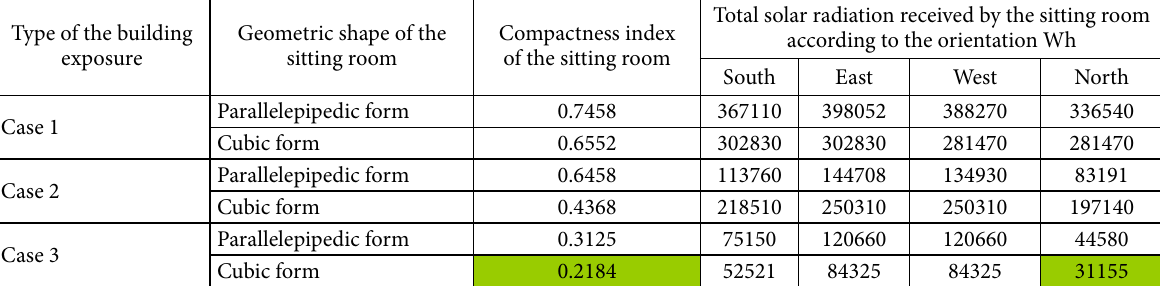
Table 5. Total solar radiation received by the sitting room according to the orientation and geometric shapes Type of the building Geometric shape of the exposure sitting room